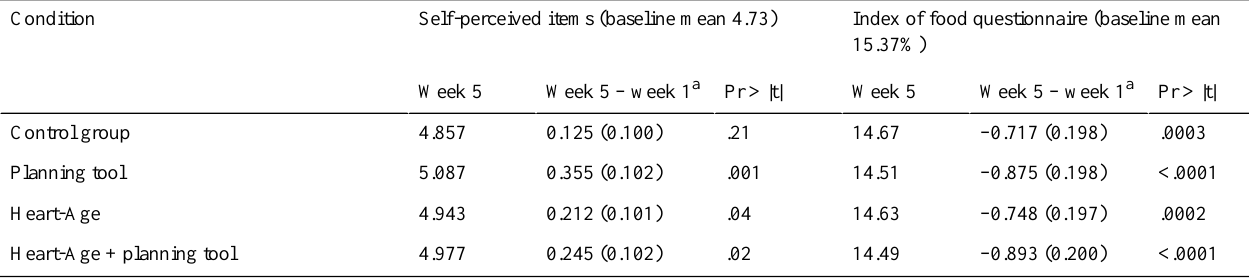
Table 2. Saturated fat intake by primary outcome (self-perceived and index of food